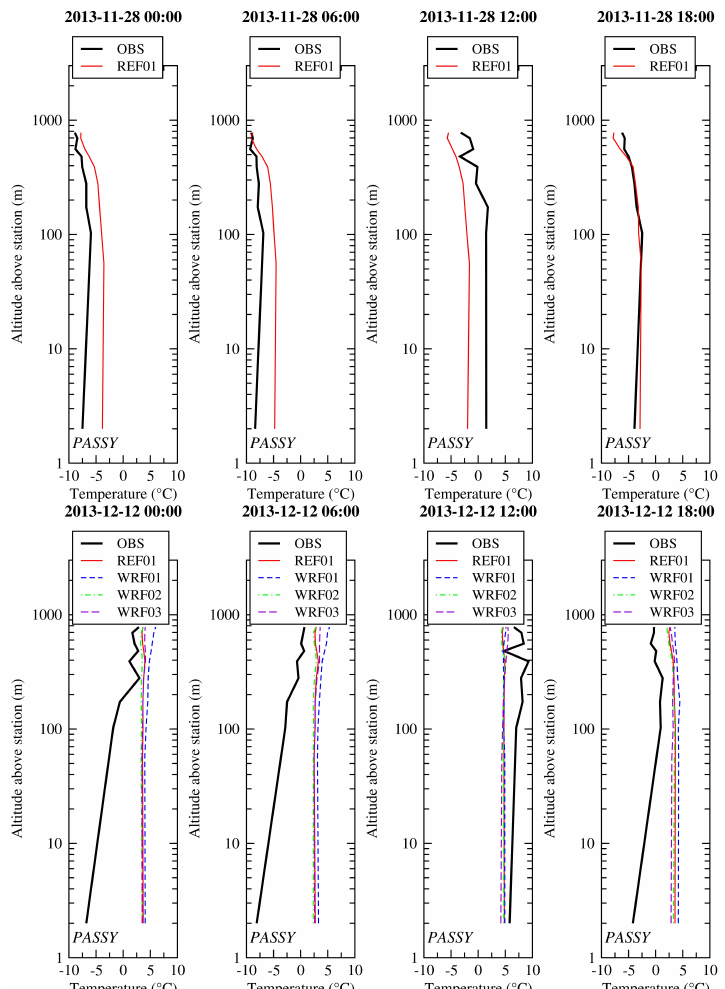
Figure 11. Vertical profile of 2 m temperature at Passy station for two days at 1 ⁄ 90 ◦ resolution (ARV0011) on 28 November and 12 December for the reference simulations and the various test cases when